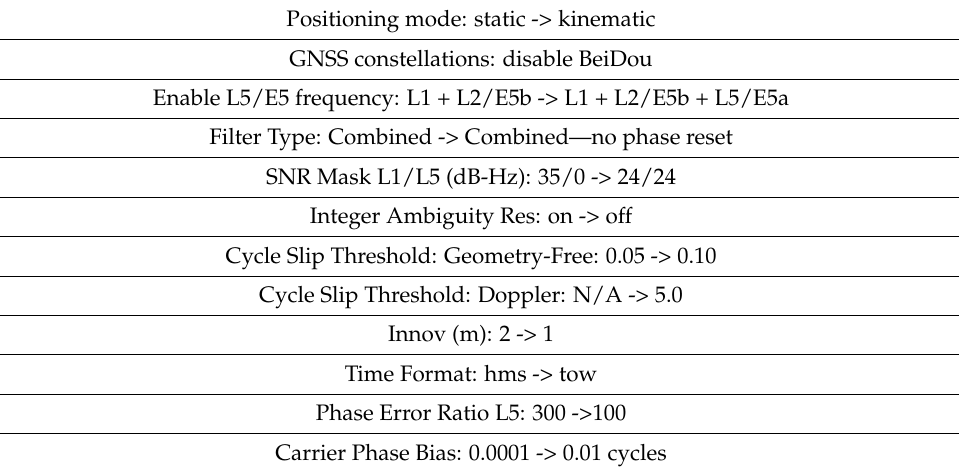
Table 1. Summary of changes to the demo5 b34eRTKlib code default settings file